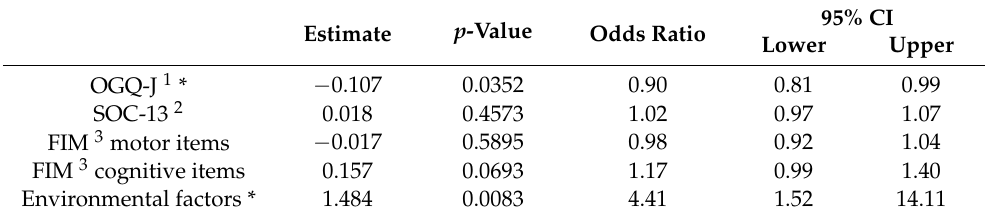
Table 3. Binary logistic regression analyses of variables potentially associated with life satisfaction ( n